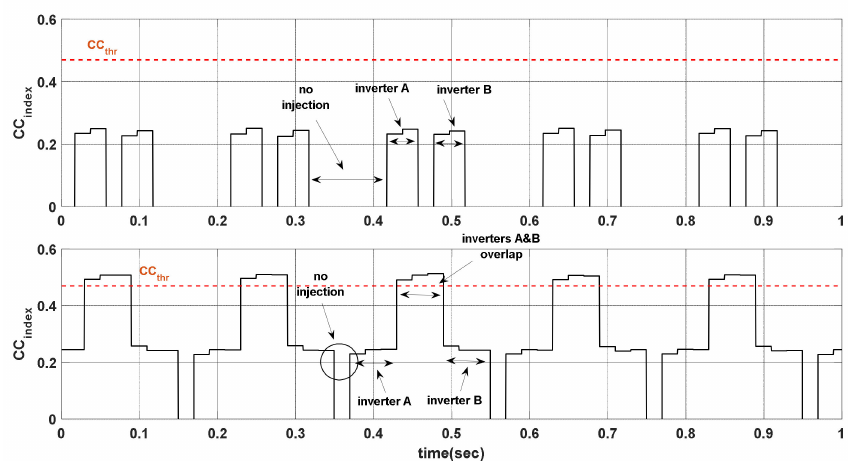
Figure 11. Evolution of CC index in an islanded operation for the two injection patterns, ( top graph ) 1 / 10 cycles, ( bottom graph ) 6 / 10 cycles.